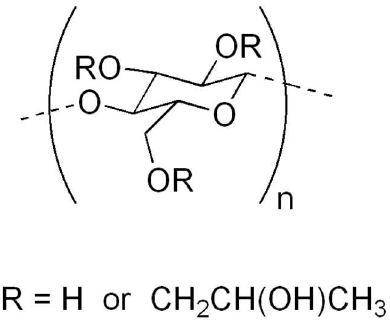
Figure 3. Hydroxypropyl cellulose gelificant.